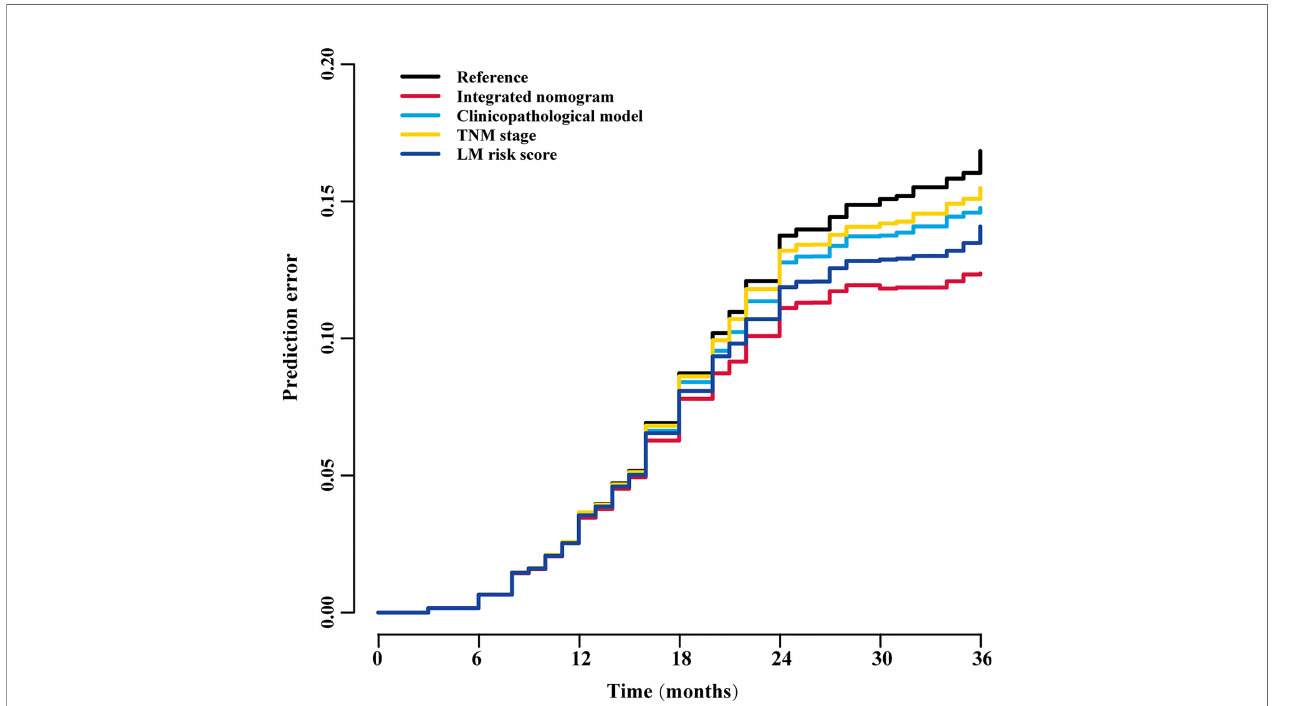
FIGURE 9 | Prediction error curves for each model for stratifying liver metastasis in all patients. TNM, tumor-node-metastasis; LM, liver metastasis.